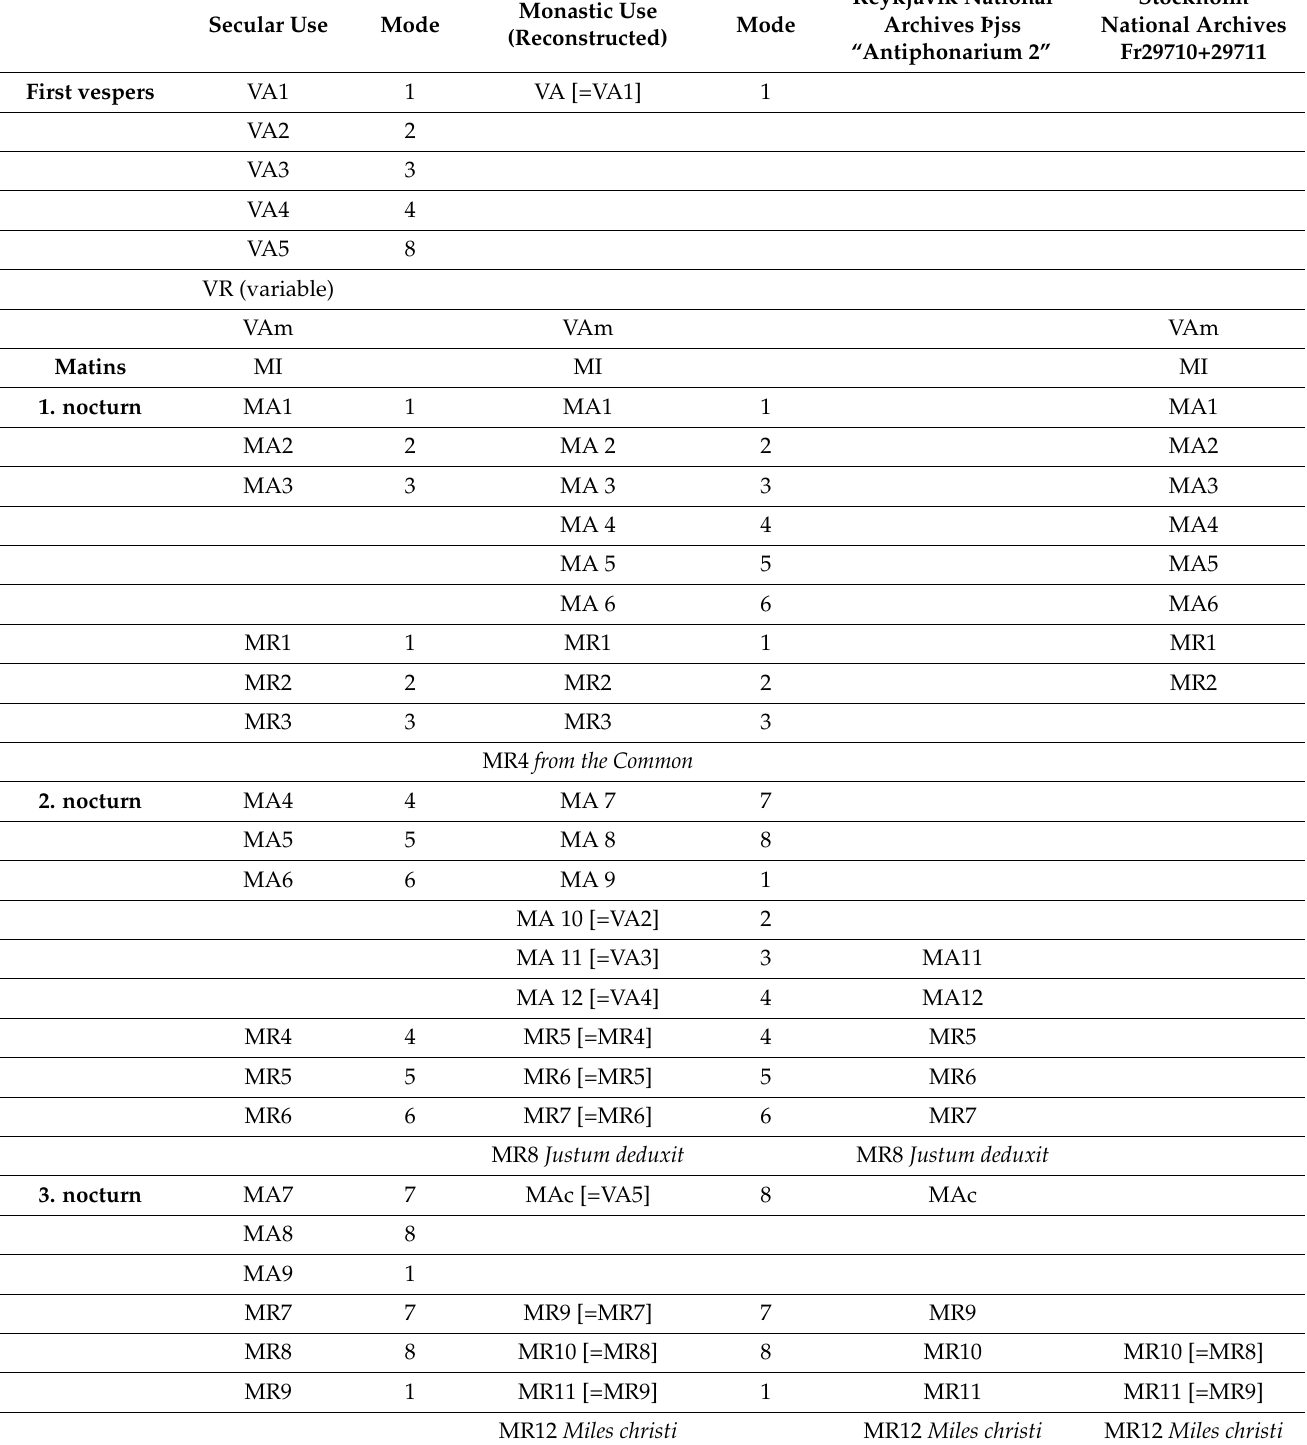
Table 1. Overview over the chants in the Olav’s Office 20